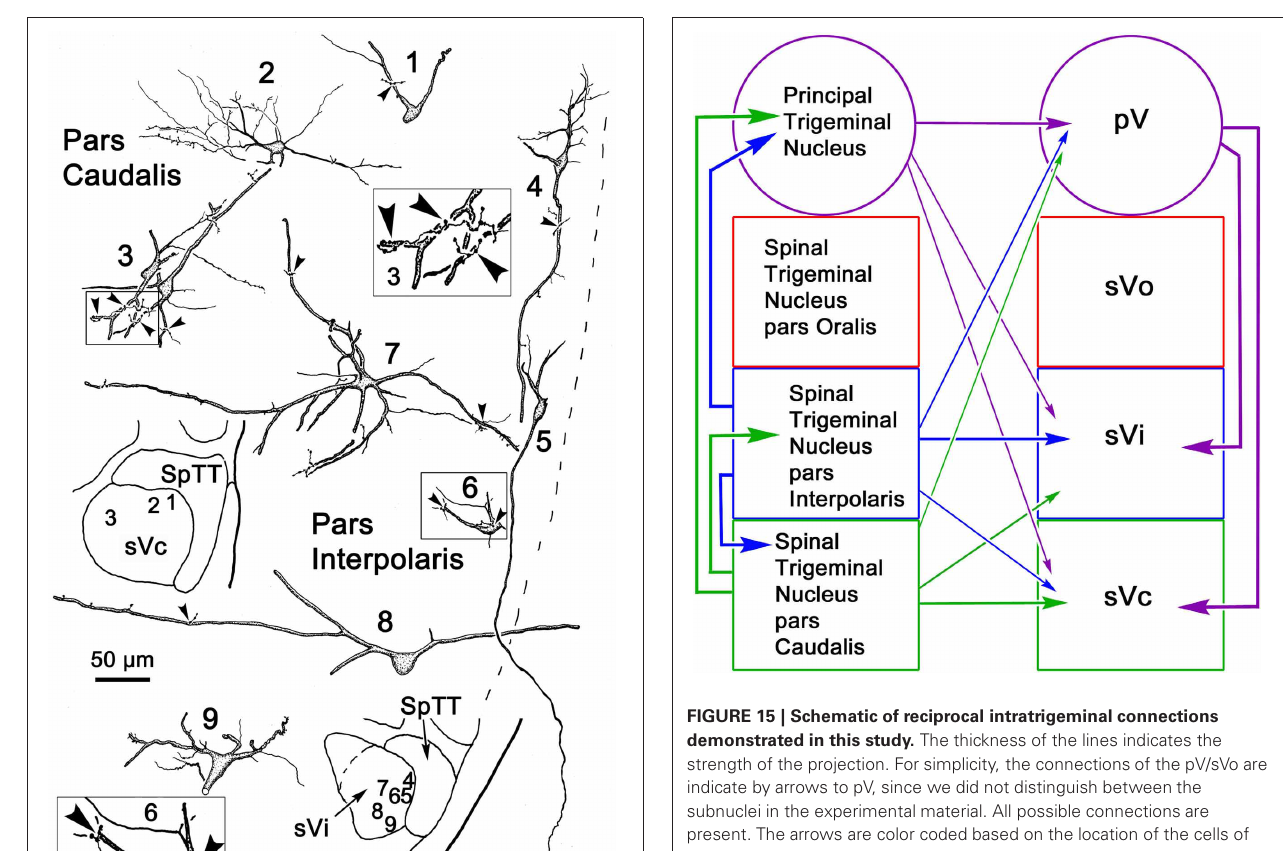
this descending projection is paralleled by an ascending crossed